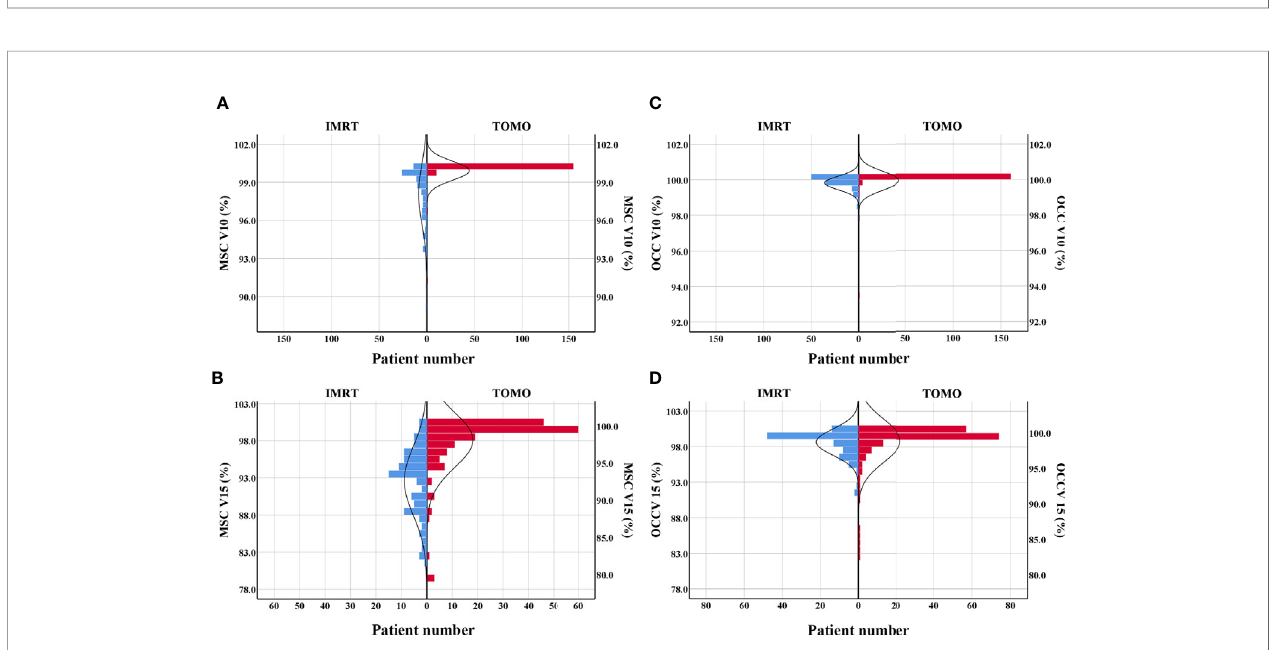
FIGURE 2 | (A , F) LASSO coef fi cient pro fi les of 19 clinical features and 19 MSC and OCC based dosimetric parameters; (B , G) Ten-fold cross-validation for tuning parameter selection in MSC and OCC based LASSO model. (C – E, H – J) ROC curve for MSC and OCC based model: (C, H) Training group, (D, I) Testing group, (E, J) Entire group. The point on the curve is cutoff value for RS and the following bracket contains speci fi city and sensitivity. Abbreviation: RS, risk score; OCC, oral cavity contouring; MSC, mucosa surface contouring; AUC, area under curve; CI, con fi dence interval.